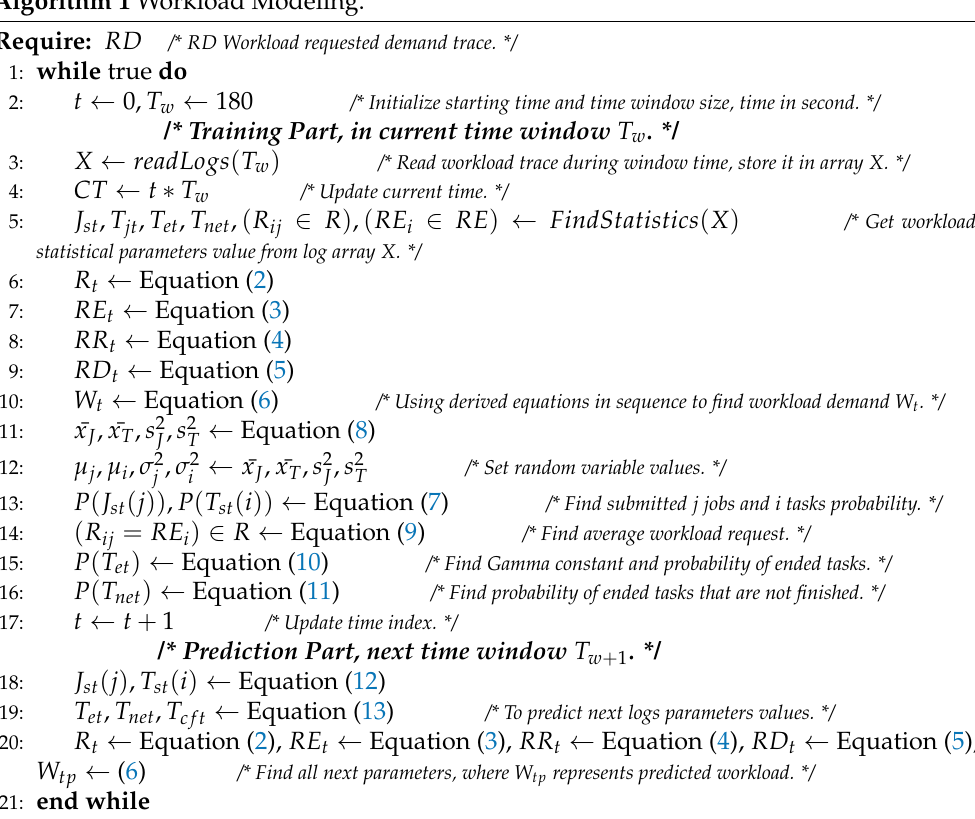
Algorithm 1 Workload Modeling.